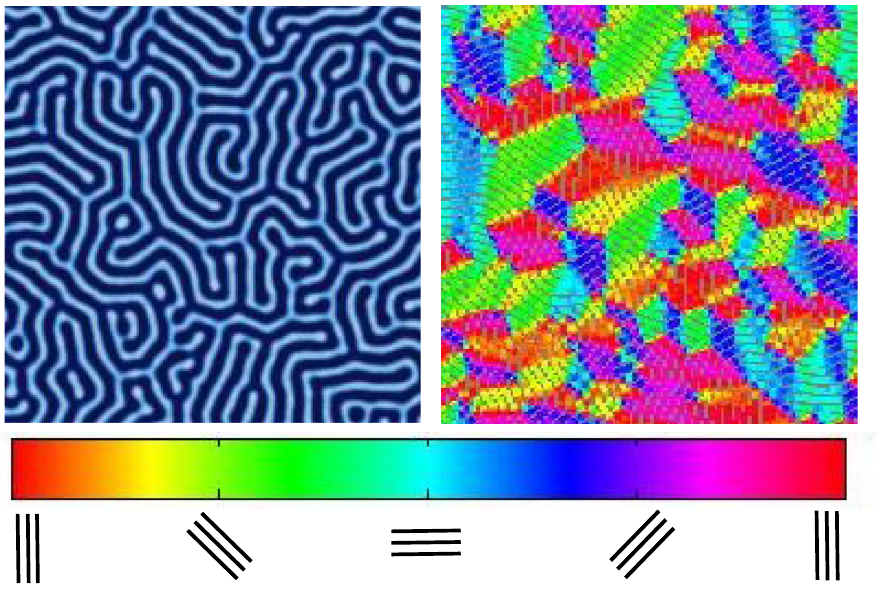
Figure 2. False-color imaging is used to show local lamellae orientation. The image here is obtained from an isothermally annealed simulation.